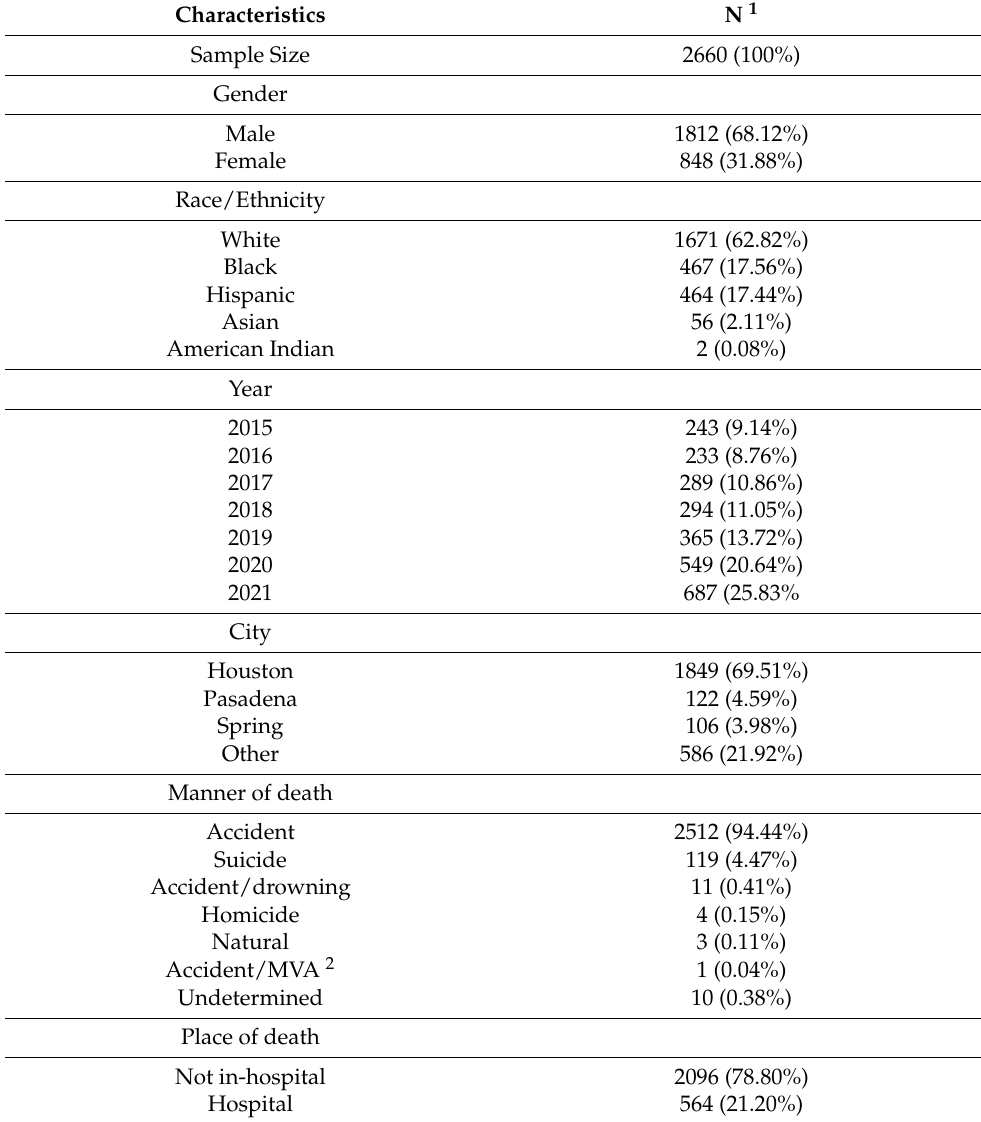
Table 1. Demographic characteristics of 2660 patients who died of opioid-related overdoses in metropolitan Houston area between 1 January 2015 to 31 December